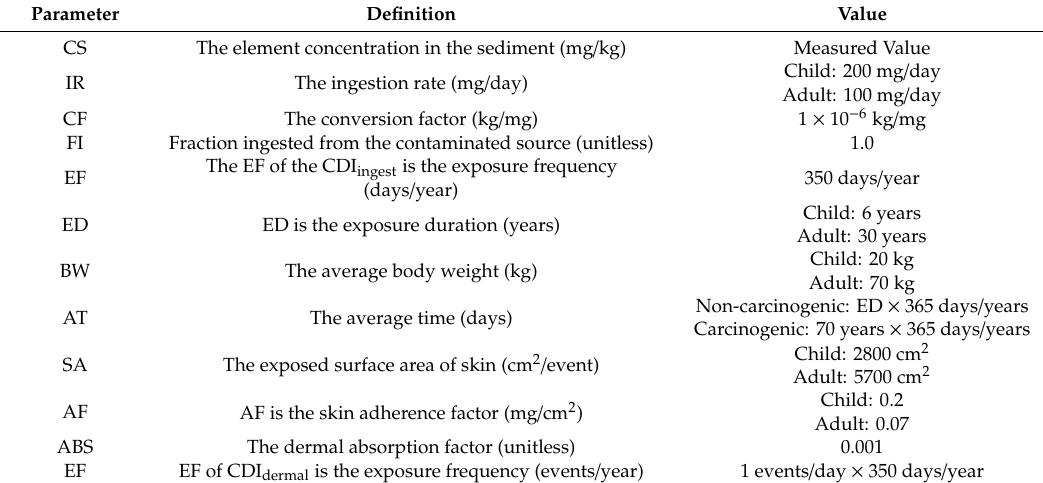
Table 2. Definition and reference value of some parameters for health risk